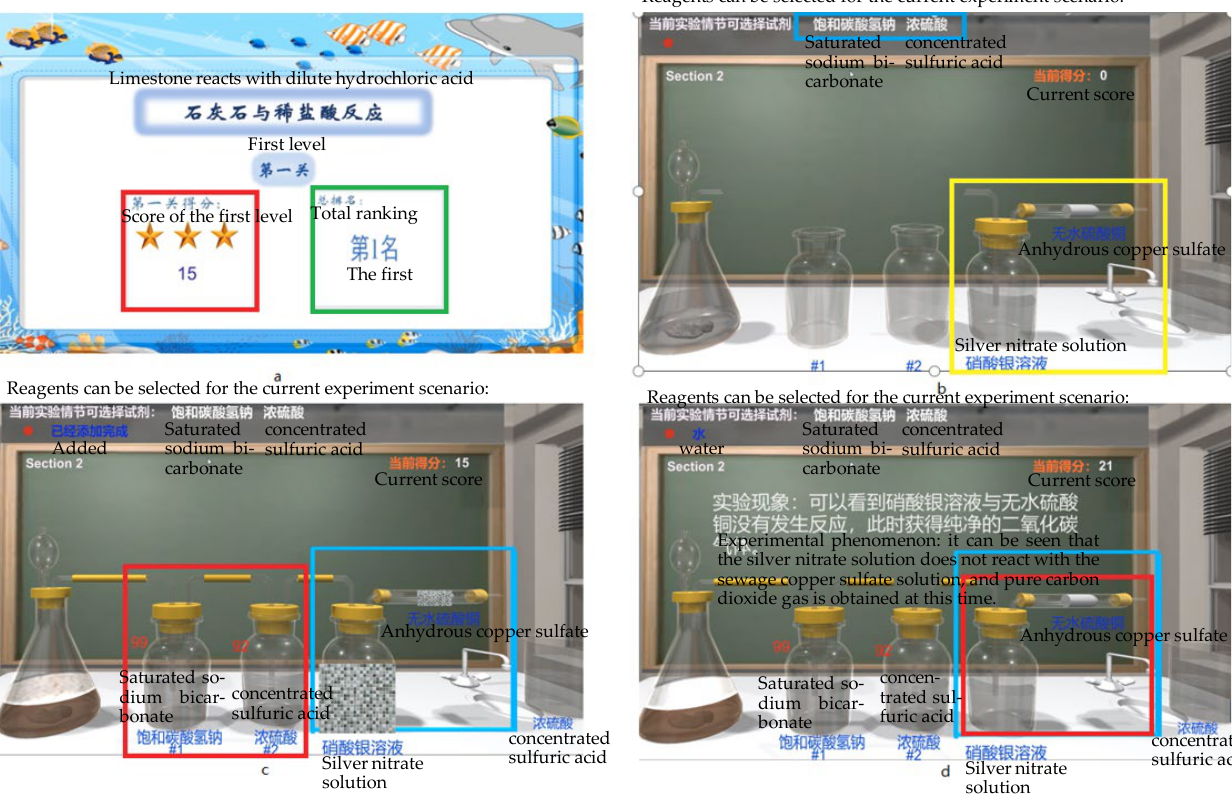
Figure 8. Limestone and dilute hydrochloric acid experiment scene 3. ( a ). Score interface after the first round. ( b ). The second drug selection interface. ( c ). The second level knowledge question and answer interface. ( d ). The second test phenomenon interface.